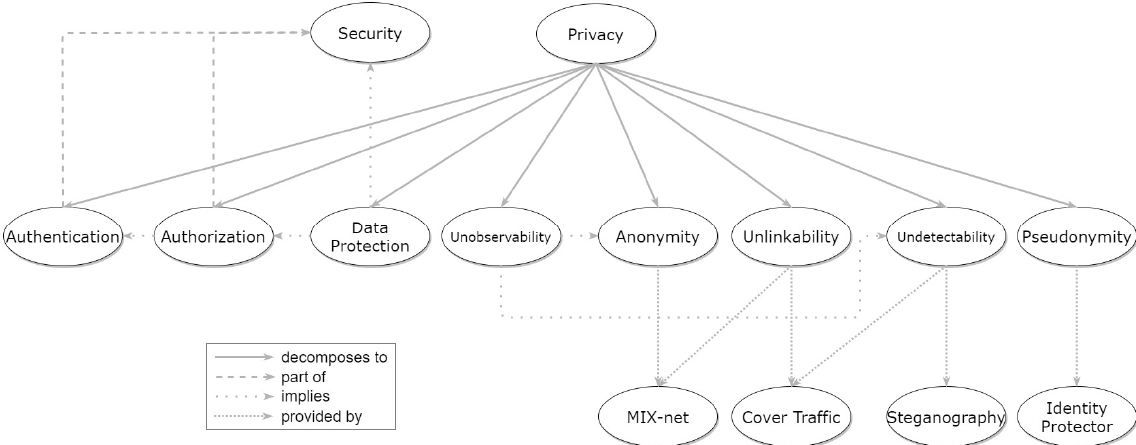
Figure 19. Hierarchical graph of Privacy properties and relevant patterns.